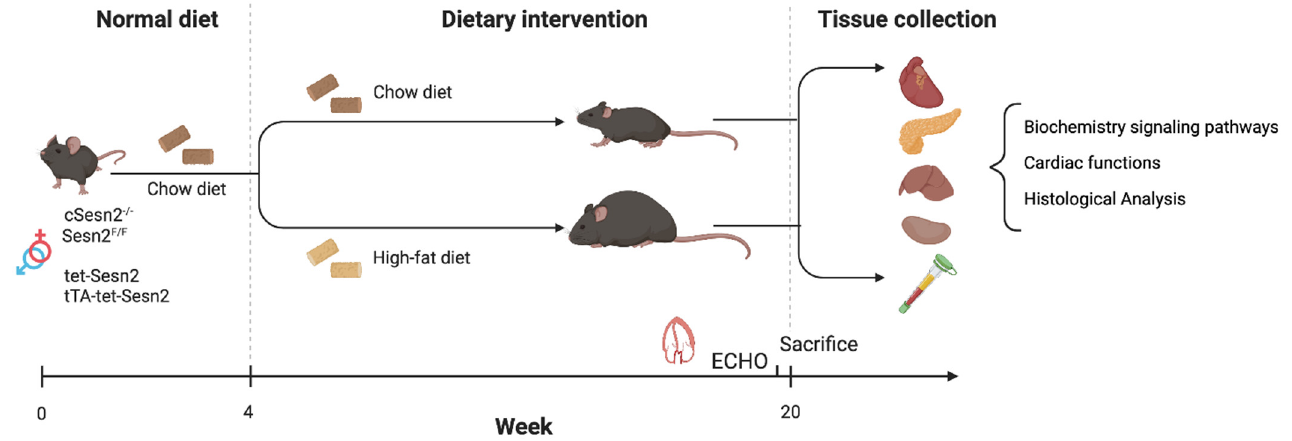
Figure 1. Experimental design and timeline. cSesn2 − / − , tTa-tet-Sesn2, and their wildtype littermates (Sesn2 flox / flox and tet-Sesn2, respectively) were randomly assigned to a normal chow (NC) diet or a high-fat (HF) diet at 4 weeks of age. After 16 weeks of dietary intervention, echocardiogram data and tissue samples were collected for bioanalysis.